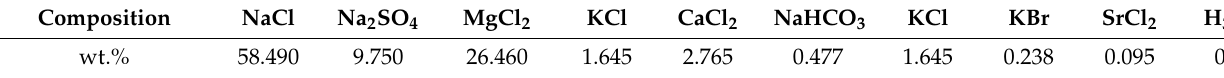
Table 2. Chemical composition of the sea salt used in this study.